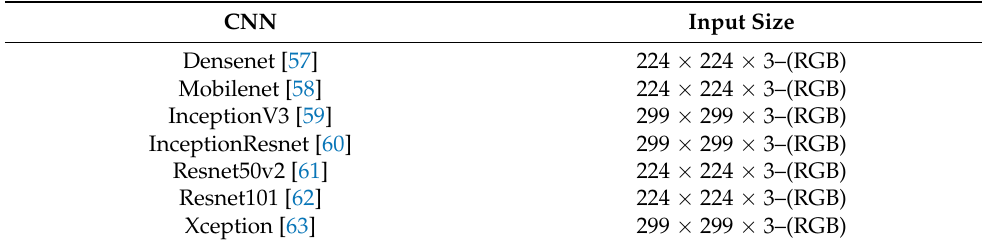
Table 1. Pre-trained CNNs with RGB color pattern used in this study.